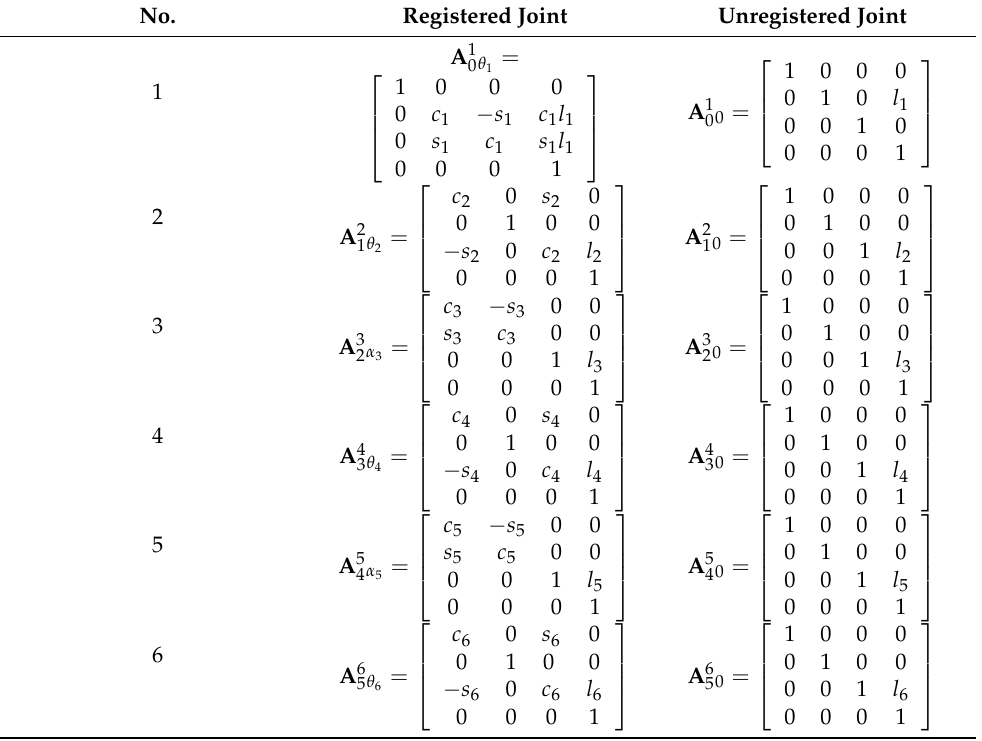
Table 3. Transformation matrices for kinematic joints registered and unregistered in the system. No. Registered